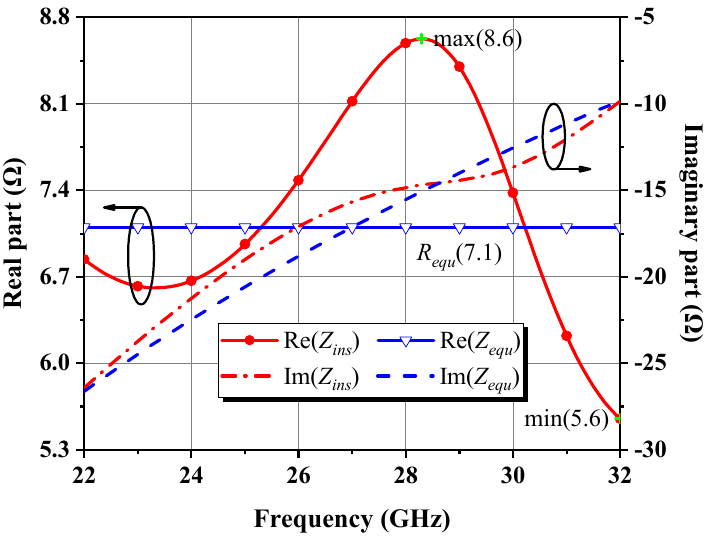
Figure 14. Comparison of the real and imaginary parts of Z ins and Z equ .